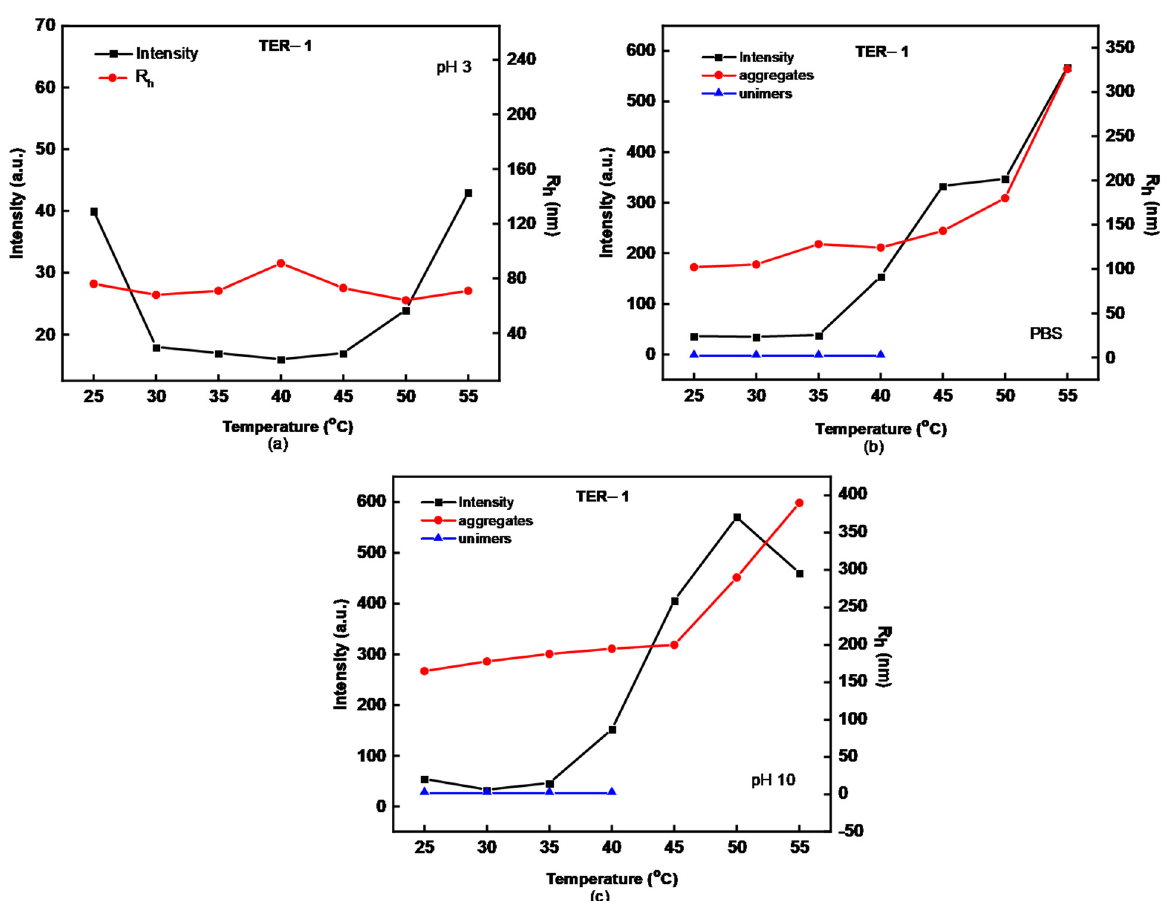
Figure 5. Scattering intensity (I) and the hydrodynamic radius (R h ) as a function of temperature at ( a ) pH = 3, ( b ) PBS and ( c ) pH = 10 for TER-1 terpolymer.